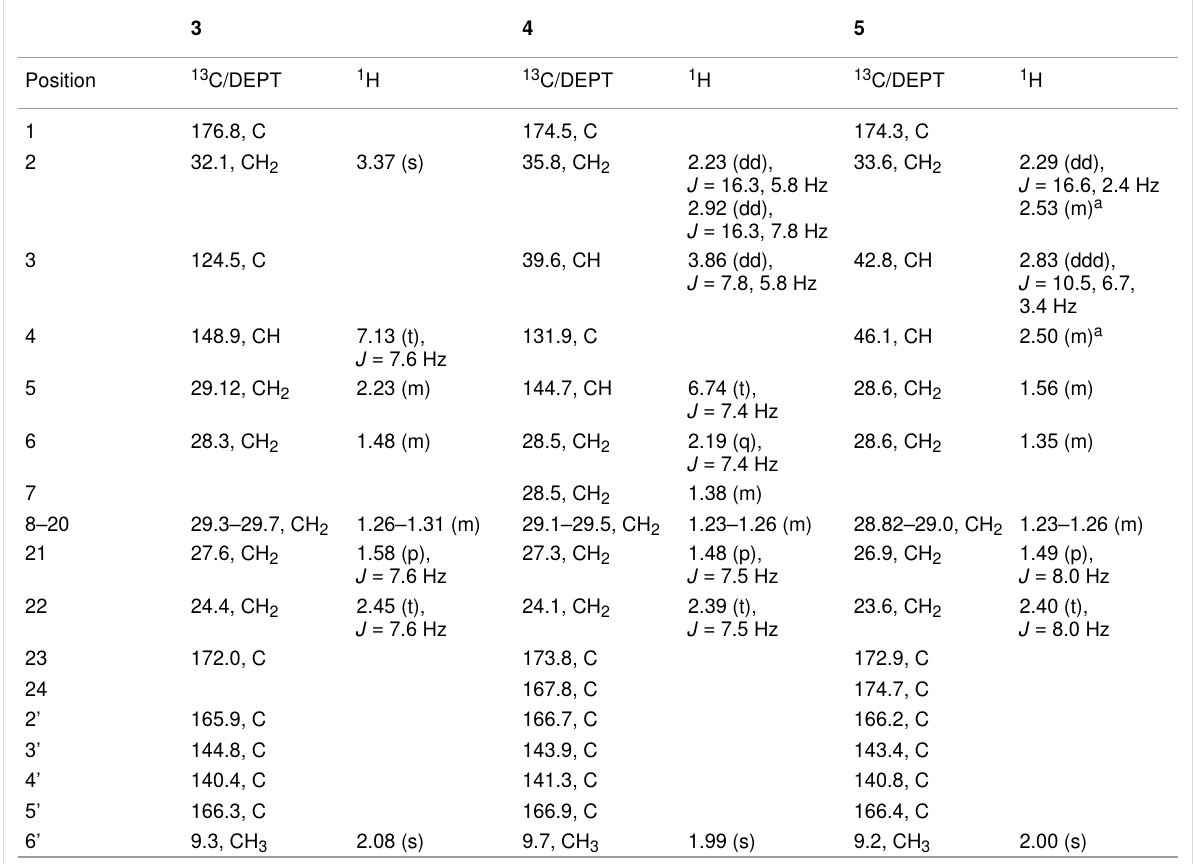
Table 2: 1 H and 13 C NMR data for 3 (in CDCl 3 ) and compounds 4 and 5 (in DMSO- d 6